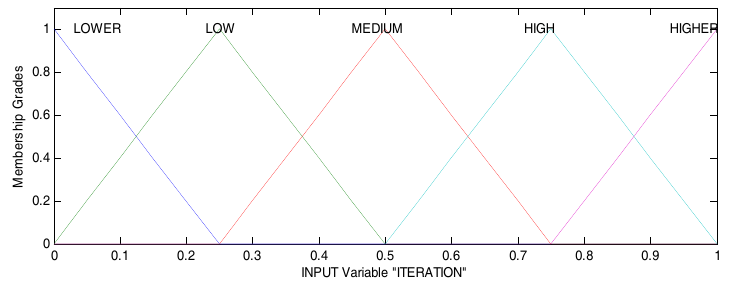
Figure 6. Input variable of DPFFWA-I (Iteration).